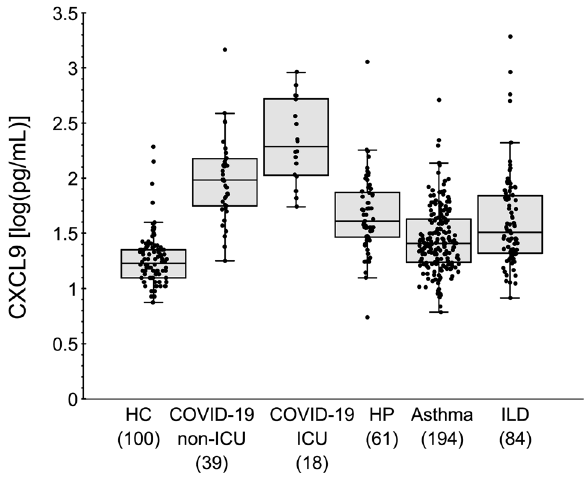
Figure 4. Distribution of serum CXCL9 levels. Levels of CXCL9 in HCs, COVID-19 patients not admitted to the ICU (Non-ICU) and those admitted to the ICU (ICU), and patients with asthma, ILDs, and HP, respectively. Results are shown as individual data points (circles) with medians (bars) and interquartile ranges (box). Whiskers extend to the minimum and maximum values excluding